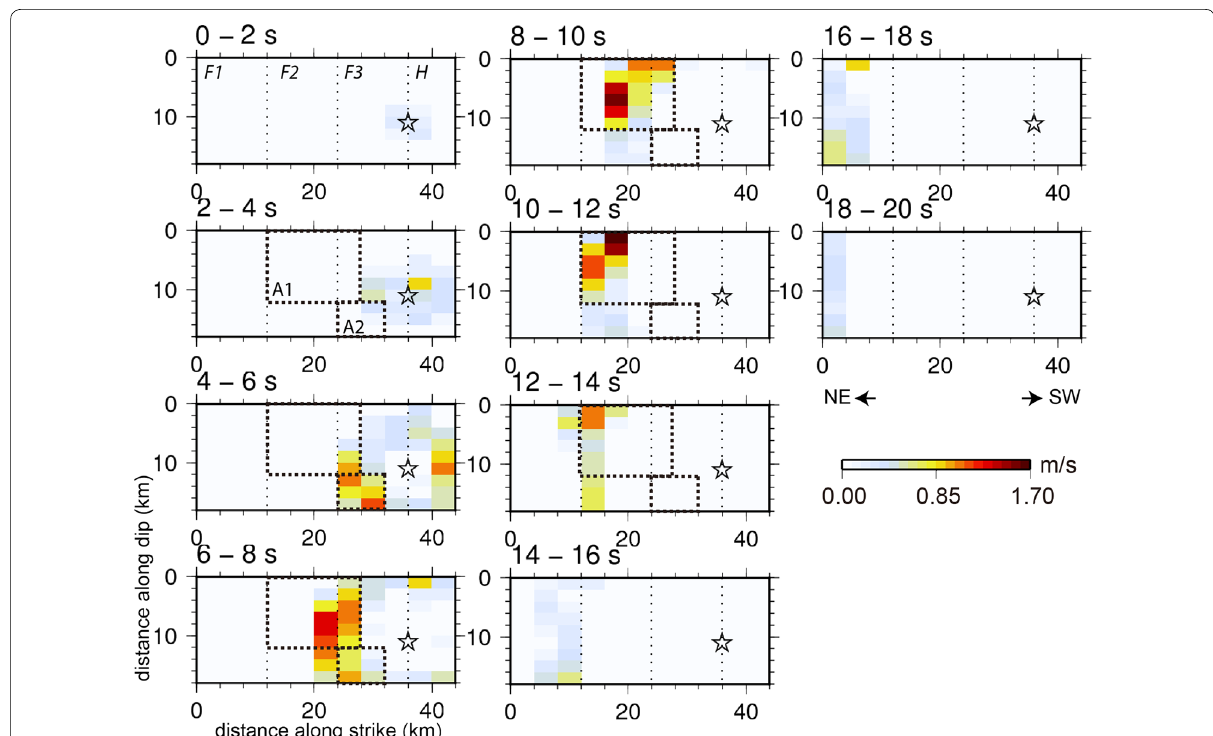
Fig. 8 Snapshot of the rupture progress in terms of slip velocity at 2-s intervals. Stars indicate the rupture starting point. The number at the top of each frame shows the time after the start of the